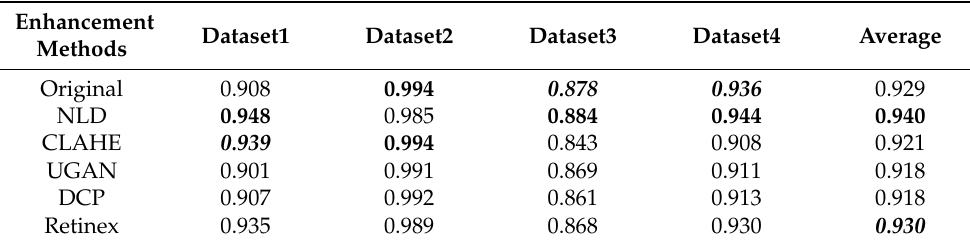
Table 2. Average precision (AP 50 ) of sea cucumber detection at multiple scenes by YOLOv7 (Bold font indicates the best result and italic indicates the second-best result).